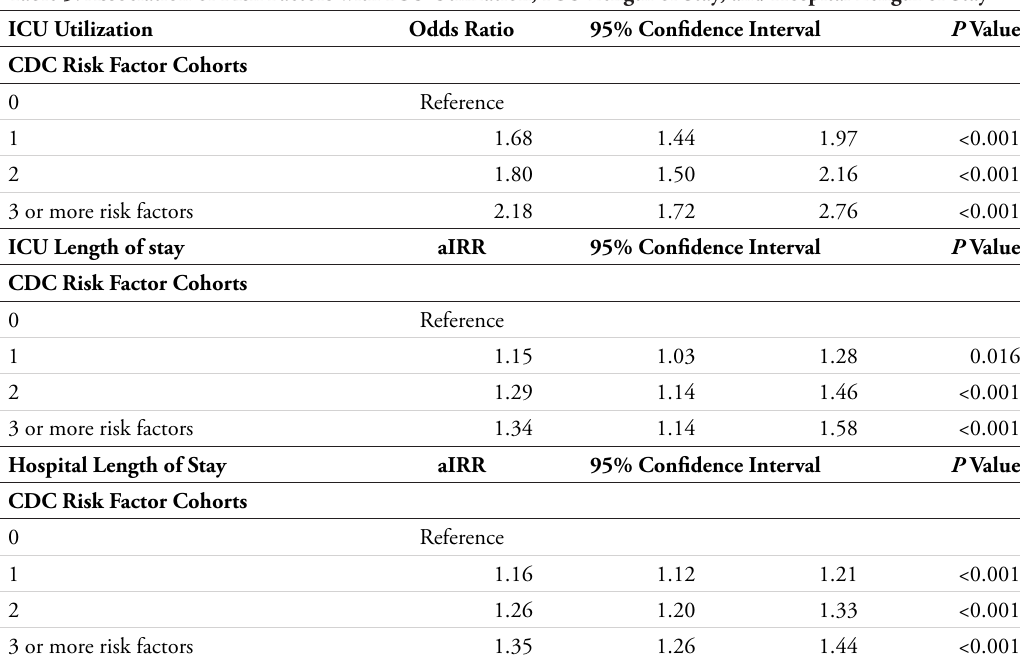
Table 5. Association of Risk Factors with ICU Utilization, ICU Length of Stay, and Hospital Length of Stay ICU